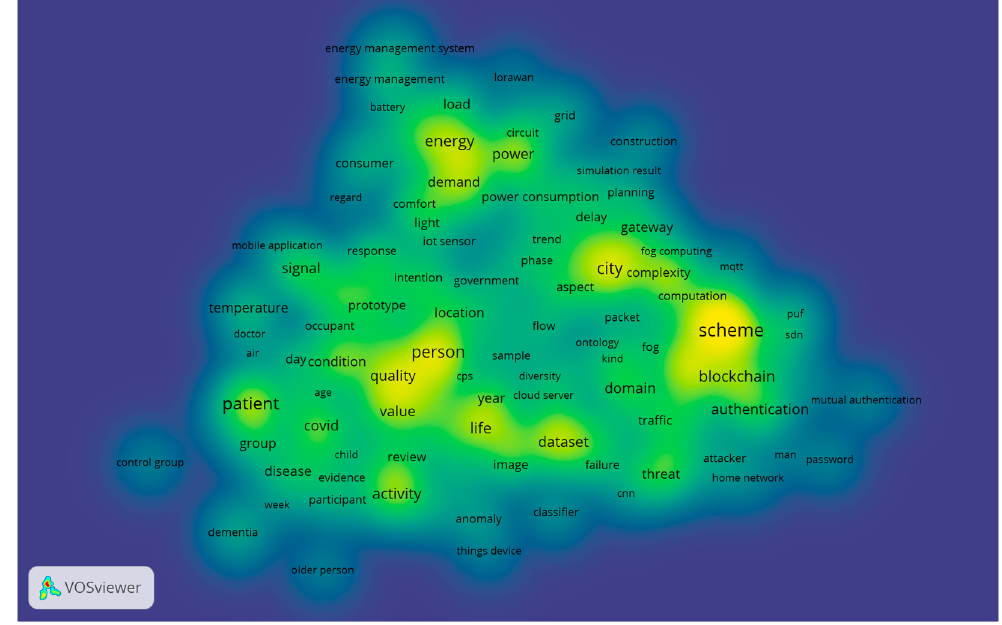
Figure 19. Density visualization for 2022.